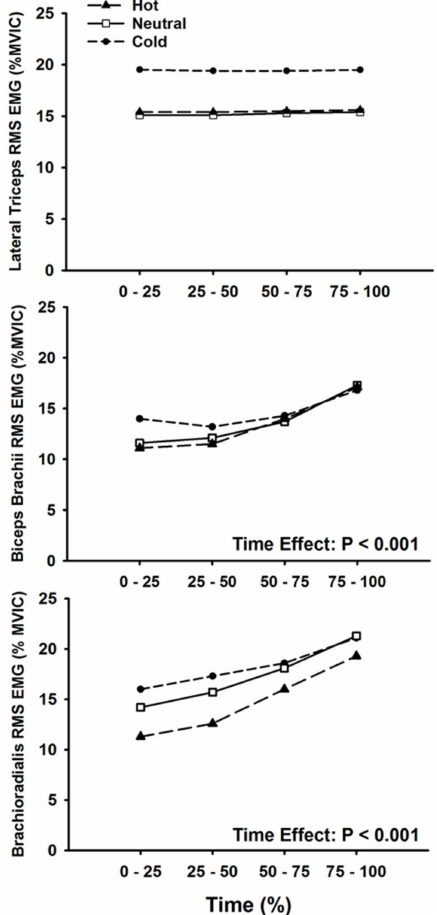
Figure A2. EMG throughout the fatiguing task. There was a significant increase in muscle activity of the biceps brachii and brachioradialis during the fatiguing task (time e ff ect: p < 0.001). Data are reported as mean values. Standard deviation bars were removed for